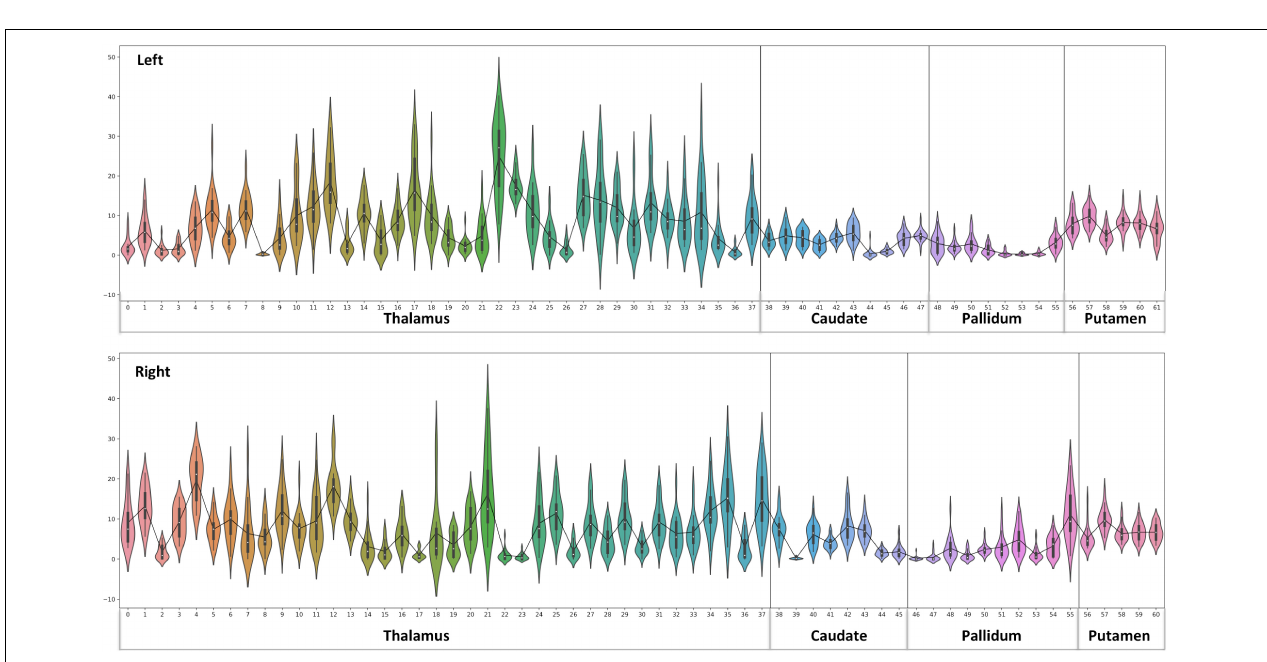
FIGURE 8 | Violin plot of Diamagnetic sources, i.e., myelin and calcium: The violin plot highlights only the mean of each parcel. The black-line plot shows only the mean values of all parcels in all subjects. First, note the overall lower values for the caudate and pallidum, and in contrast, putamen and several parcels in the Th show consistently higher pallidum parcel values. Second, the violin plot reveals inter-individual variability.